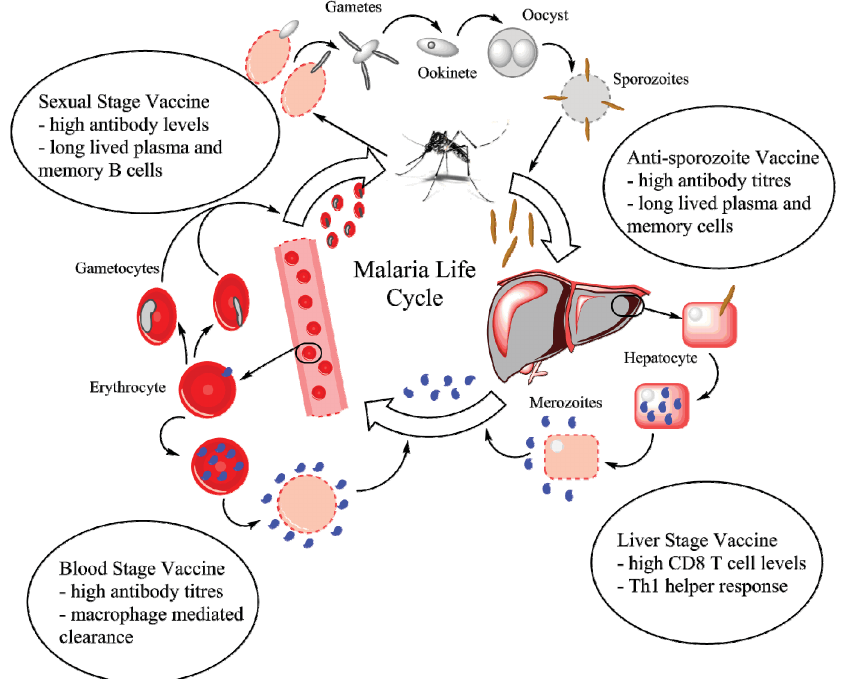
Figure 1. The life cycle of the malaria parasite. A mosquito delivers sporozoites into the blood stream, which quickly travel to and infect hepatocytes. Inside liver cells, the sporozoites differentiate and proliferate to form merozoites, which upon release infect erythrocytes. Proliferation and release continues inside infected erythrocytes with a small fraction of merozoites differentiating into gametocytes. The gametocyte-infected erythrocytes are taken up by mosquitoes inside which gametes interact to form a zygote (ookinete) and eventually an oocyst, which produces sporozoites. The bubbles contain the primary immune response required against each stage. Figure developed using ChemBioDraw Ultra 14 (PerkinElmer Informatics, Waltham, MA, USA,